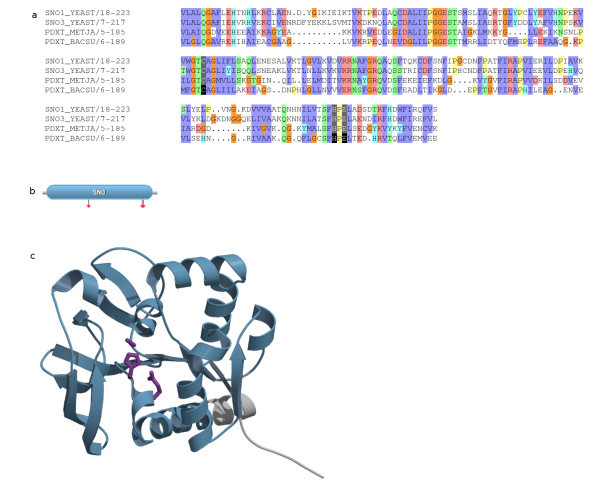
Sample multiple sequence alignment with active site markup in Stockholm format as used in the Pfam flatfiles. AS indicates an experimental active site, pAS indicates a Pfam predicted active site and sAS indicates a UniProtKB predicted active site.